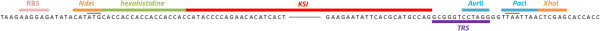
Schematic diagram of the expression vector pET31HT. Green: Polyhistidine tag coding sequence; red: ketosteroid isomerase gene; purple: thrombin recognition site coding sequence; light blue: cloning site restriction enzymes. Start and stop translation codons are crowned in brown.